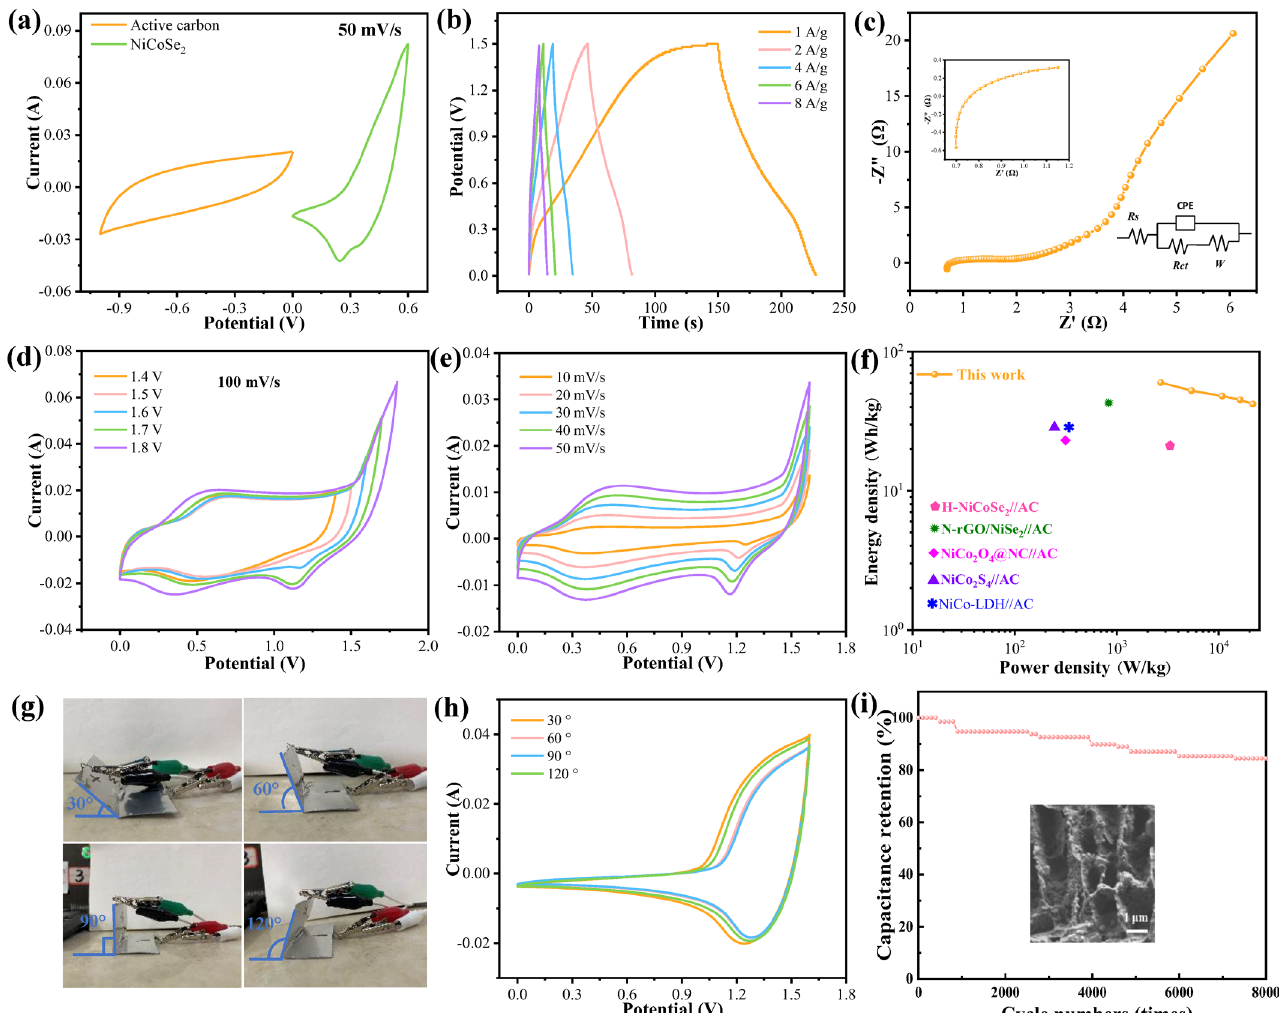
Figure 4. Electrochemical characterization of ASC. ( a ) CV curves of 0.4Se-NiCo-LDH and active carbon, ( b ) GCD curves, ( c ) Nyquist plots, ( d ) CV curves with various voltage windows, ( e ) CV curves with various scan rates, ( f ) Ragone plots, ( g ) digital photographs of the folded device ( h ) CV curves of device at different bending angles, ( i ) cycling performance and SEM image after cycling.